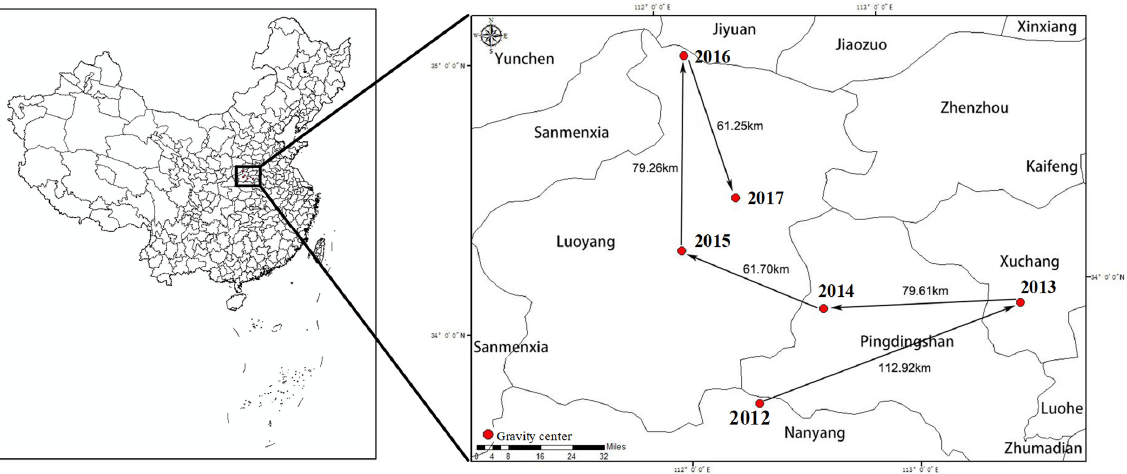
Figure 2. The movement trajectory of the inferiority gravity center over time in 2012–2017. Between 2012 and 2013, the gravity center moved to the northeast area from northern Nanyang to the east of Xuchang, reaching a distance of 112.92 km, during which the infe- riority concentration in the eastern and northern areas increased significantly. From 2013 to 2014, the inferiority gravity center moved from the east to the west (from the north of Xuchang to the west of Pingdingshan); the moving rate was slower than that during the period between 2012 and 2013, reaching a distance of 79.61 km. During the period between 2014 and 2015, the gravity center of the concentration of inferiority slowly moved to the northwest area (west of Pingdingshan to the center of Luoyang), with an average moving distance of 61.70 km. From 2015 to 2017, the inferiority gravity center moved north and then south, with it still remaining in Luoyang, and the moving distance was short.